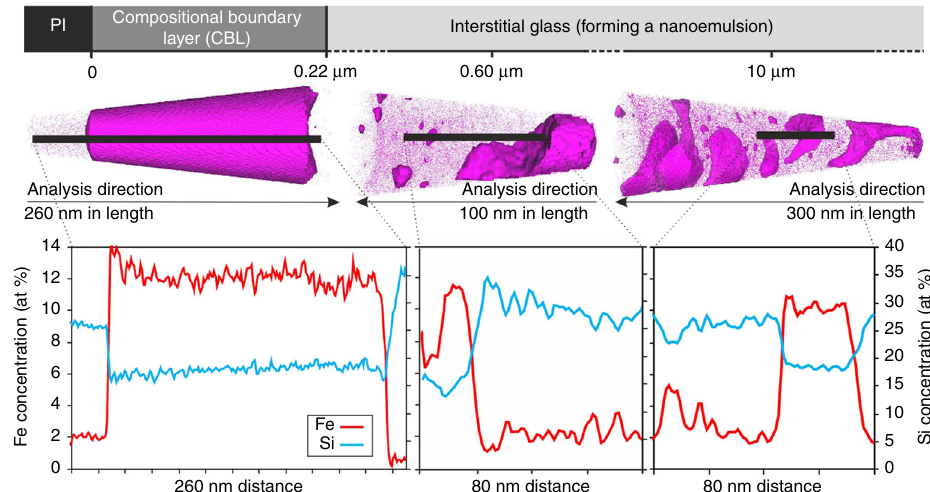
Fig. 3 Three-dimensional reconstruction of atom probe tomography (APT) data from compositional boundary layers around plagioclase. APT reconstructed data from three representative APT tips including 1D element pro fi les across compositional boundaries; K ī lauea Iki lava lake sample from 44.8 m depth (quench temperature of 1090 °C). Each dot represents a single atom, but not all the atoms are shown. One-dimensional compositions from sub-volumes represented by black bars are plotted for Fe and Si concentrations (at. %) for each APT tip. A movie of an ATP tip is shown in